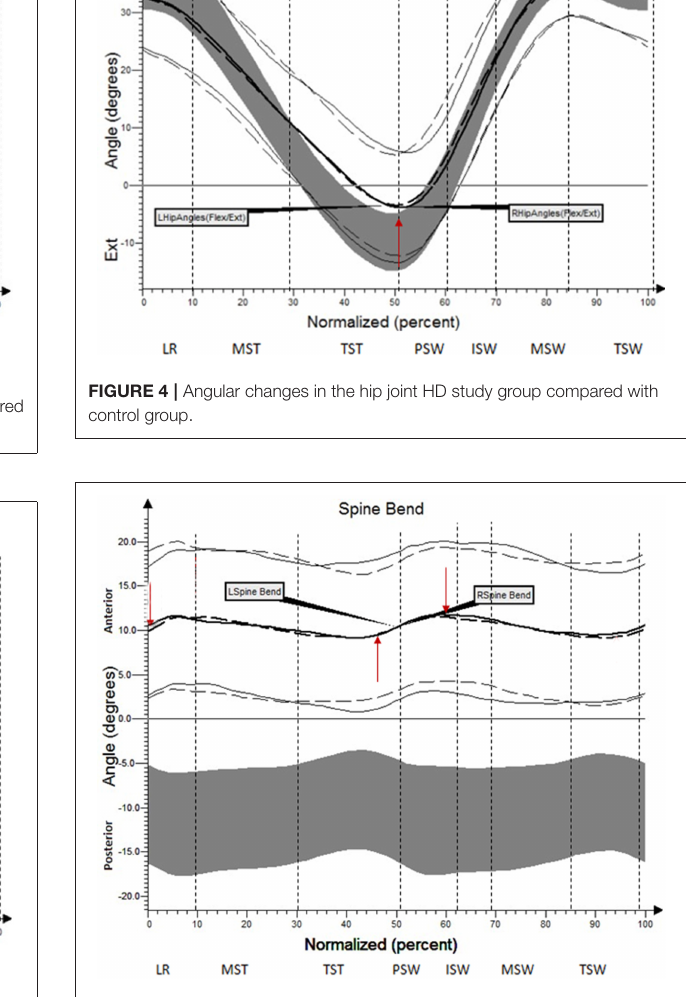
FIGURE 5 | Angular changes in the trunk (spine bend) HD study group compared with control